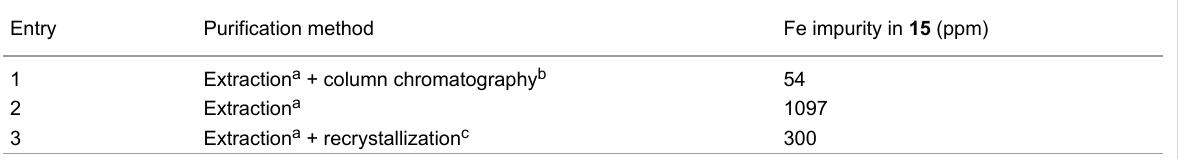
Table 3: The influence of the purification method on the amount of Fe impurities in papaveraldine ( 15 ) after